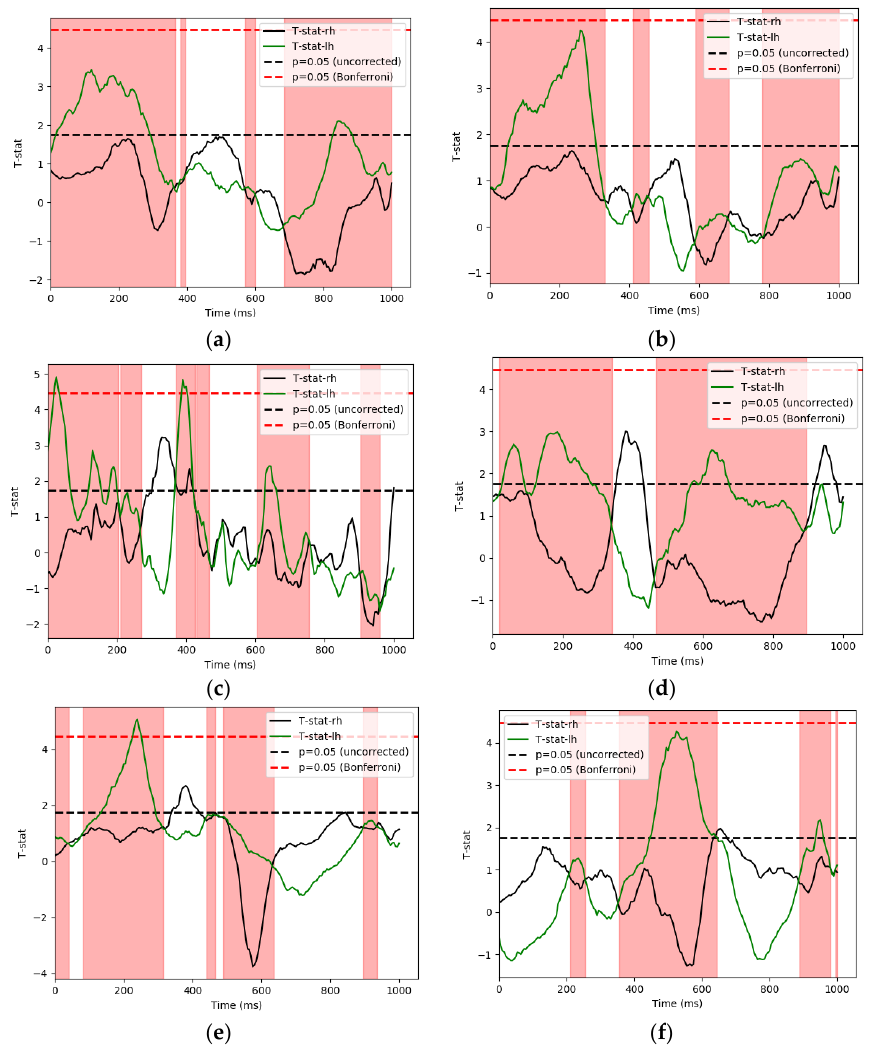
Figure 7. Here we compiled the activity pattern differences in the LH and RH. The x -axis is time, and the y -axis is t score. The red area is where the t-statistic level in the LH is larger than the RH. ( a ) FU pairing activity differences on IMF6 in the fusiform area; ( b ) FU pairing activity differences on IMF6 in the inferior temporal area; ( c ) FS pairing activity differences on IMF5 in the frontal area; ( d ) FS pairing activity differences on IMF6 in the frontal area; ( e )FS pairing activity differences on IMF6 in the inferior temporal area; ( f ) FS pairing activity differences on IMF6 in the temporal